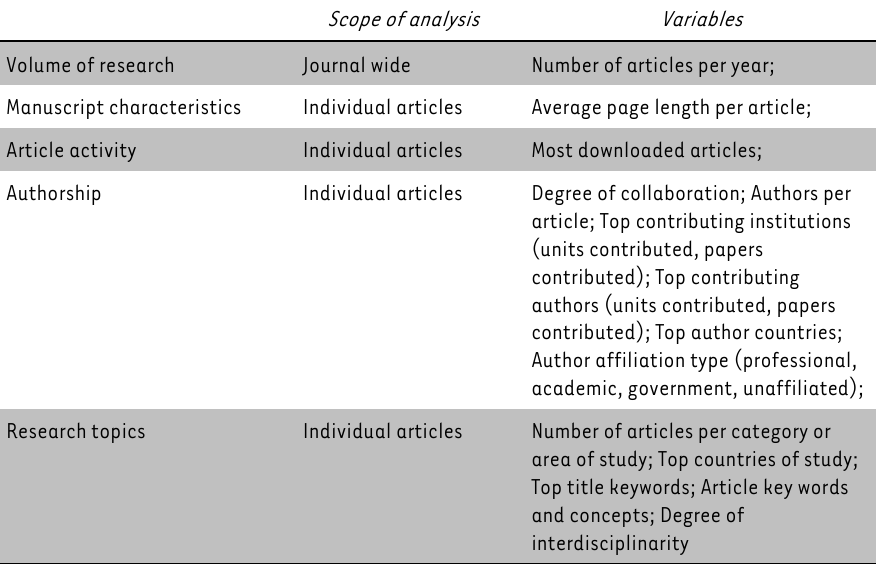
TABLE 2: Variables chosen for bibliometric